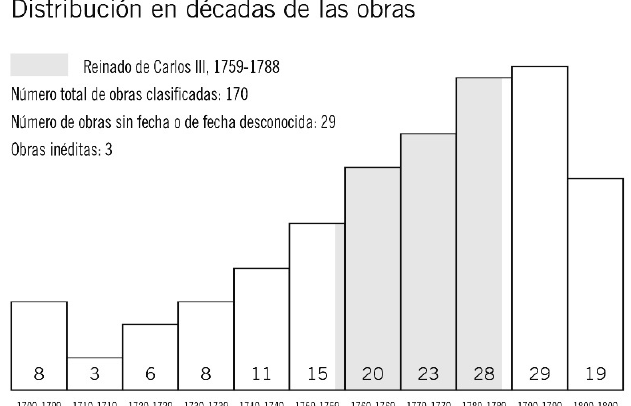
Figure 3. Distribution by decades of mathematical works. The striped area of the graph corresponds to Carlos III’s reign, 1759–1788. Total number of classified works: 170. Number of works without date or of unknown date: 29. Unpublished works: 3 ([36], p.